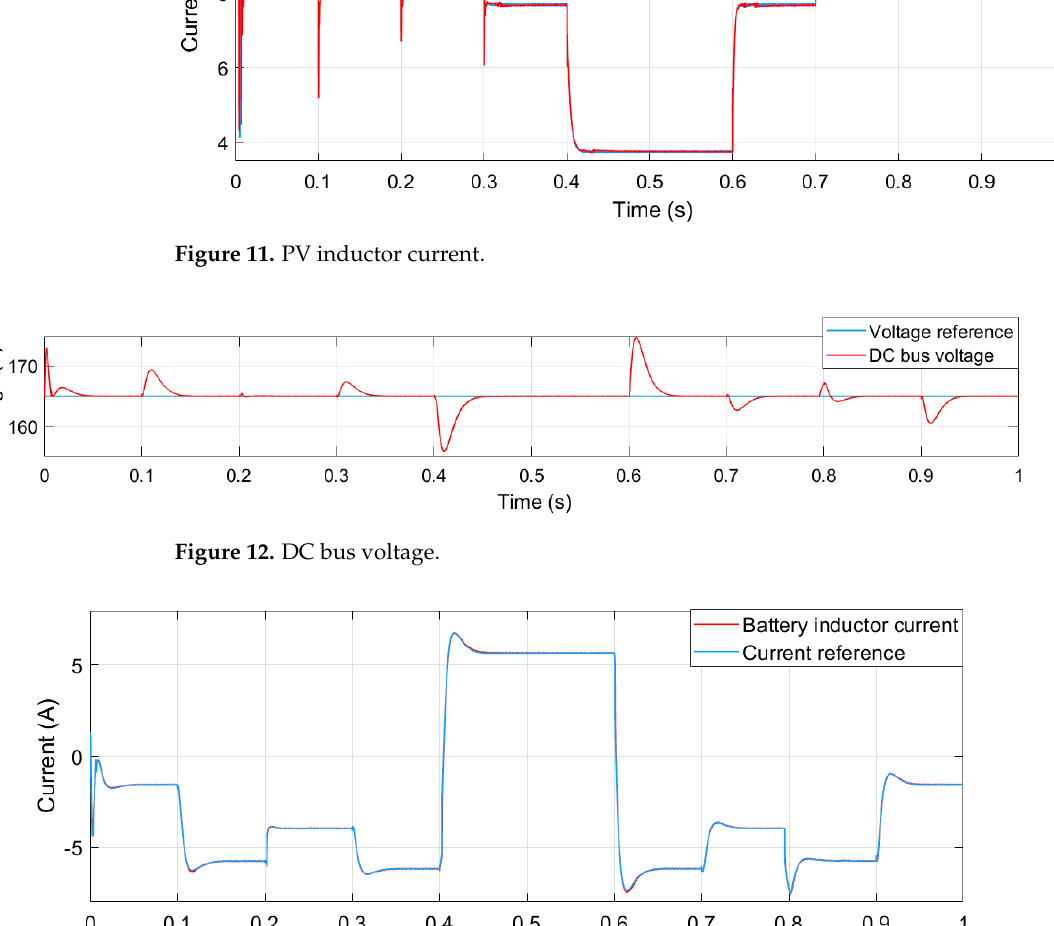
Figure 11. PV inductor current.